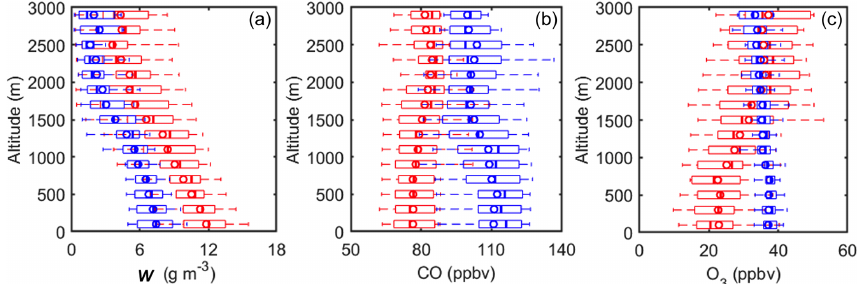
Figure 4. Vertical profiles of (a) water vapor mixing ratio ( w ), (b) carbon monoxide mixing ratio (CO), and (c) ozone mixing ratio (O 3 ) over the ENA site during the summer IOP (red) and winter IOP (blue). The mixing ratios are normalized to standard temperature and pressure (273.15K and 101.325kPa; STP). The line and circle markers represent the median and mean concentrations, and the edges of the box indicate the 25th and 75th percentiles,